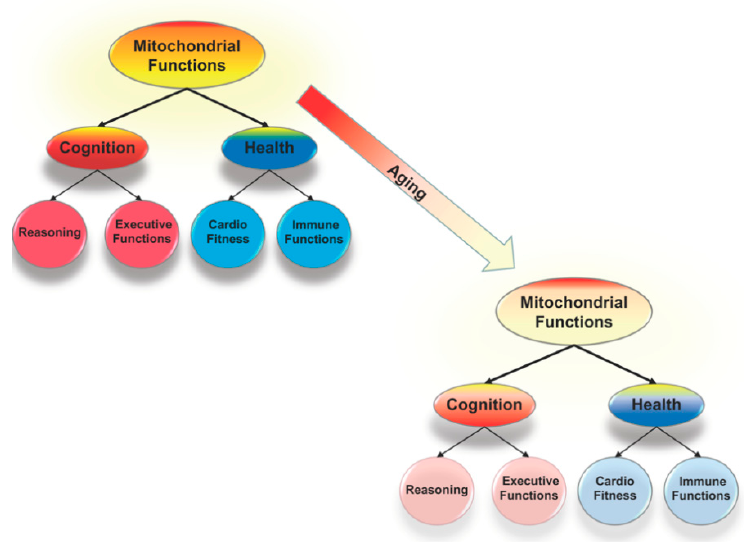
Figure 1. Mitochondrial functions, including cellular energy production and control of oxidative stress, are critical to the system of brain mechanisms that underlies all forms of cognition and link cognition and health. Reductions in mitochondrial functioning are an aspect of normal aging and compromise health and cognition. These reductions might be the key to understanding why there are correlated age-related declines across cognitive domains that are linked to declines in health.